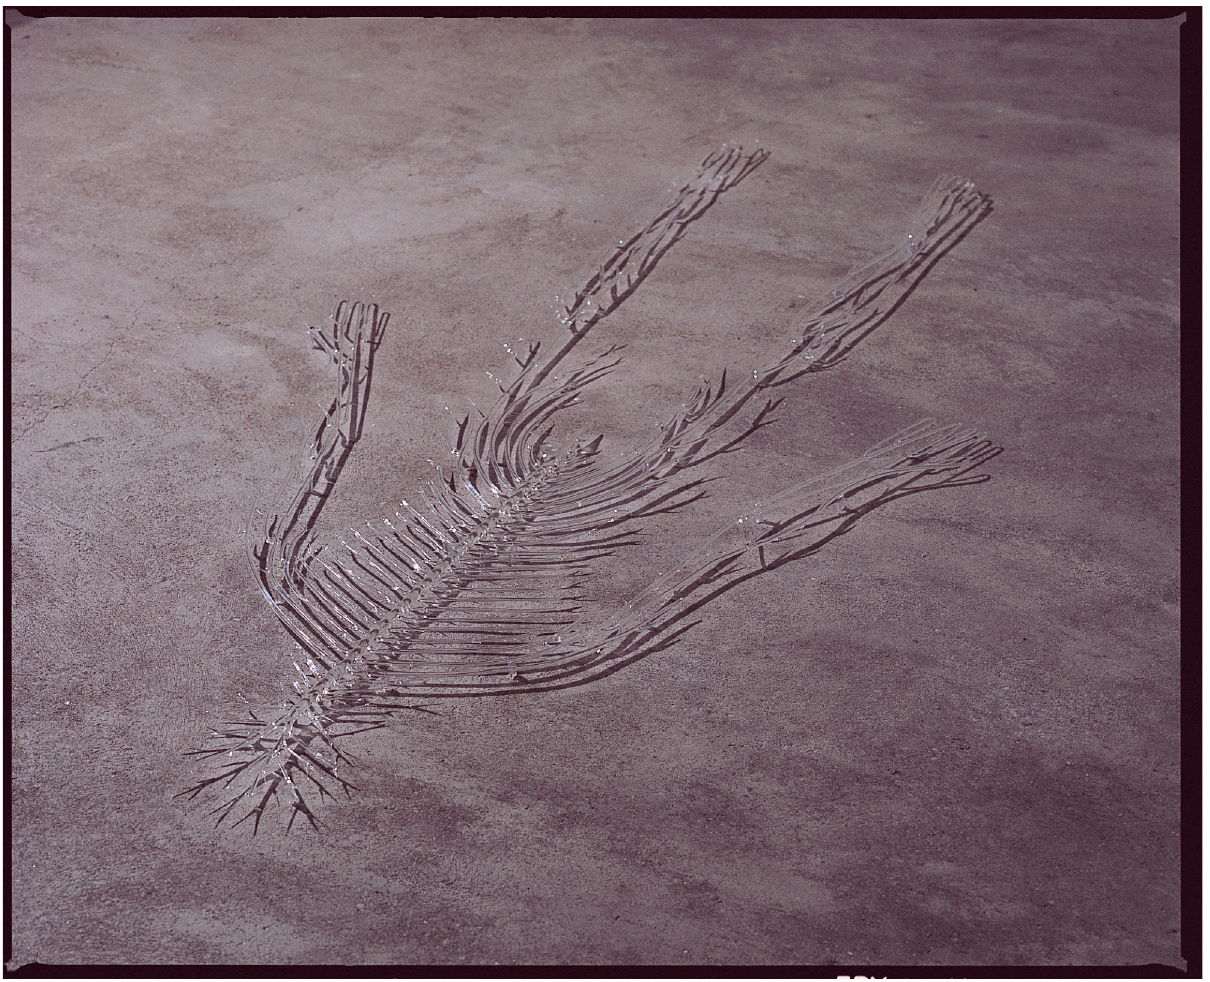
Figure 3 | Annie Cattrell, Nervous System, 1998. Courtesy of the